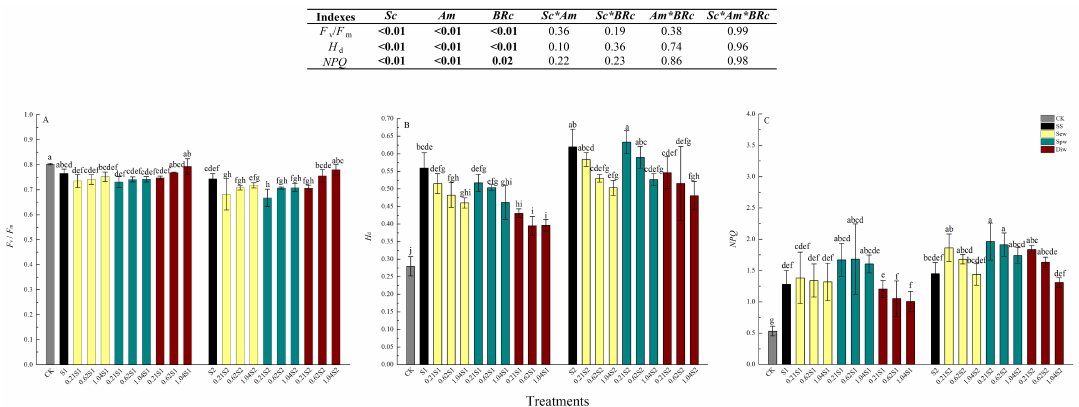
Figure 2. Effects of exogenous 24-epiBL on ( A ) maximum yield of photosystem II (PSII) ( F v / F m ), ( B ) thermal dissipation ( H d ), and ( C ) non-photochemical quenching ( NPQ ) of leaves of black locust seedlings at 100 (SS-S1) or 200 (SS-S2) mM NaCl. Other details as in Figure